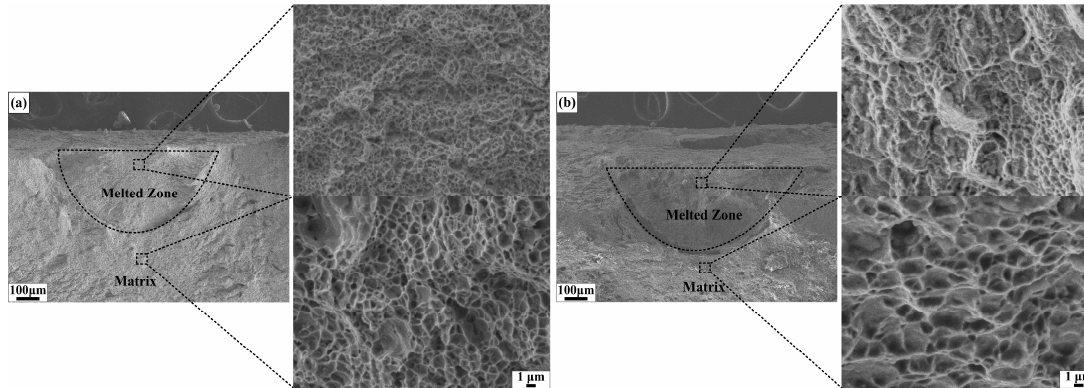
Figure 13. Fracture morphologies of LSM-treated specimen after 400 thermal cycles: ( a ) RT and ( b ) 650 °C.